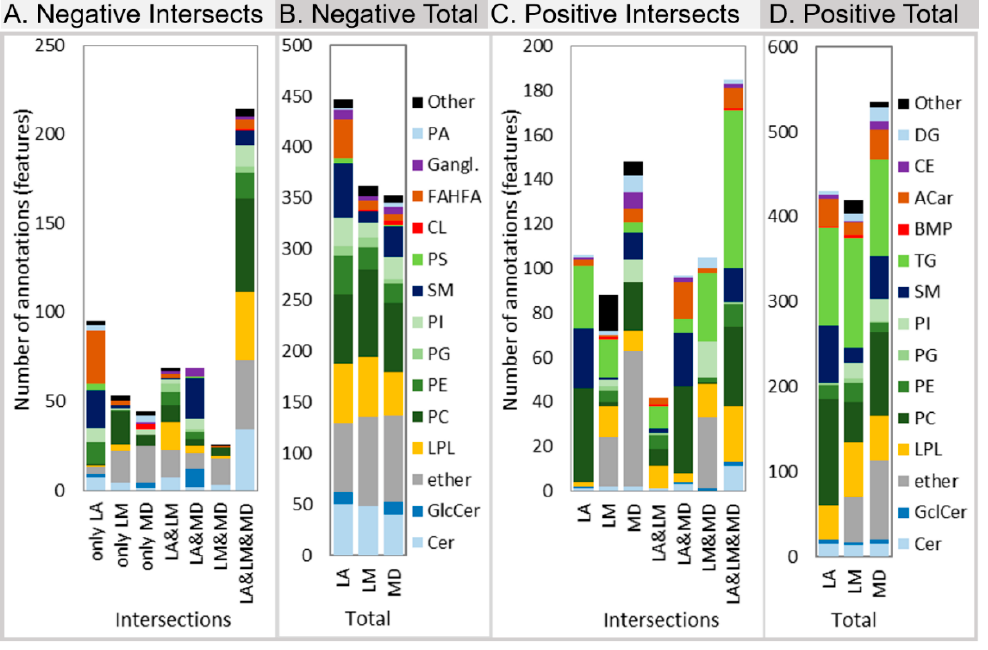
Figure 6. Comparison of annotations of features across the untargeted lipid annotation software Lipid Annotator (LA), LipidMatch (LM), and MS-DIAL (MD). Bars are color coded by lipid class. Bar graphs ( A ) and ( C ). represent the lipid annotations, which were only determined in one software (only) and those which were annotated in two or more software (annotation intersections denoted by “&”), for negative and positive mode, respectively. Bar graphs ( B ) and ( D ) represent the total annotations for each software individually divided by lipid class for negative and positive mode, respectively. Prior to this analysis both internal standards and skin ceramides were removed. Note fatty acid esters of hydroxy fatty acids (FAHFA) was removed from analysis due to likely false positives (see text). Acronyms are defined in Appendix B.